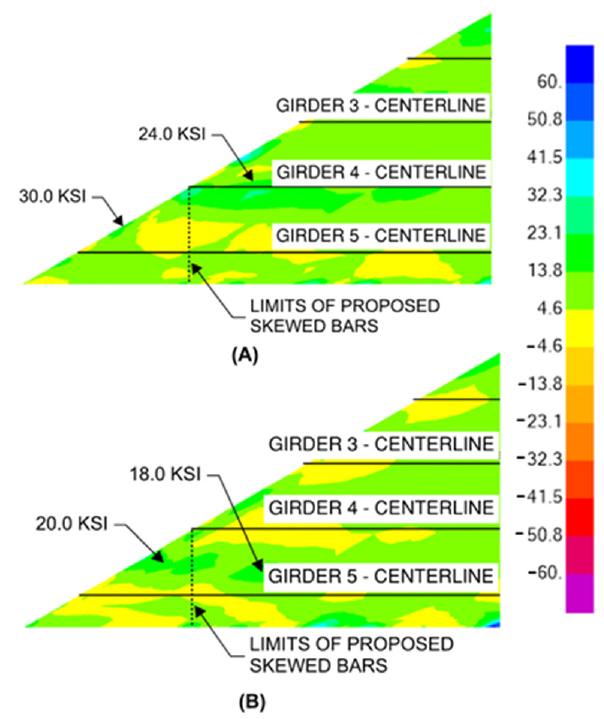
Figure 18. Stress distribution (ksi) in the top transverse reinforcement for Design Case 1, 45 degree model with ( A ) proposed reinforcement pattern and ( B ) unmodified reinforcement at acute corner.